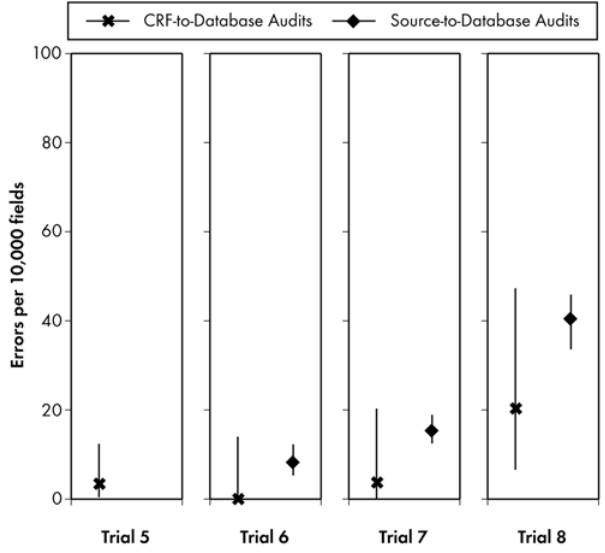
Figure 4. Source-to-database and CRF-to-database audits for Comparator Trials 5–8. These audits were undertaken to provide a ‘‘control’’ for comparison with Trials 1–4 (results displayed in Figure 3).